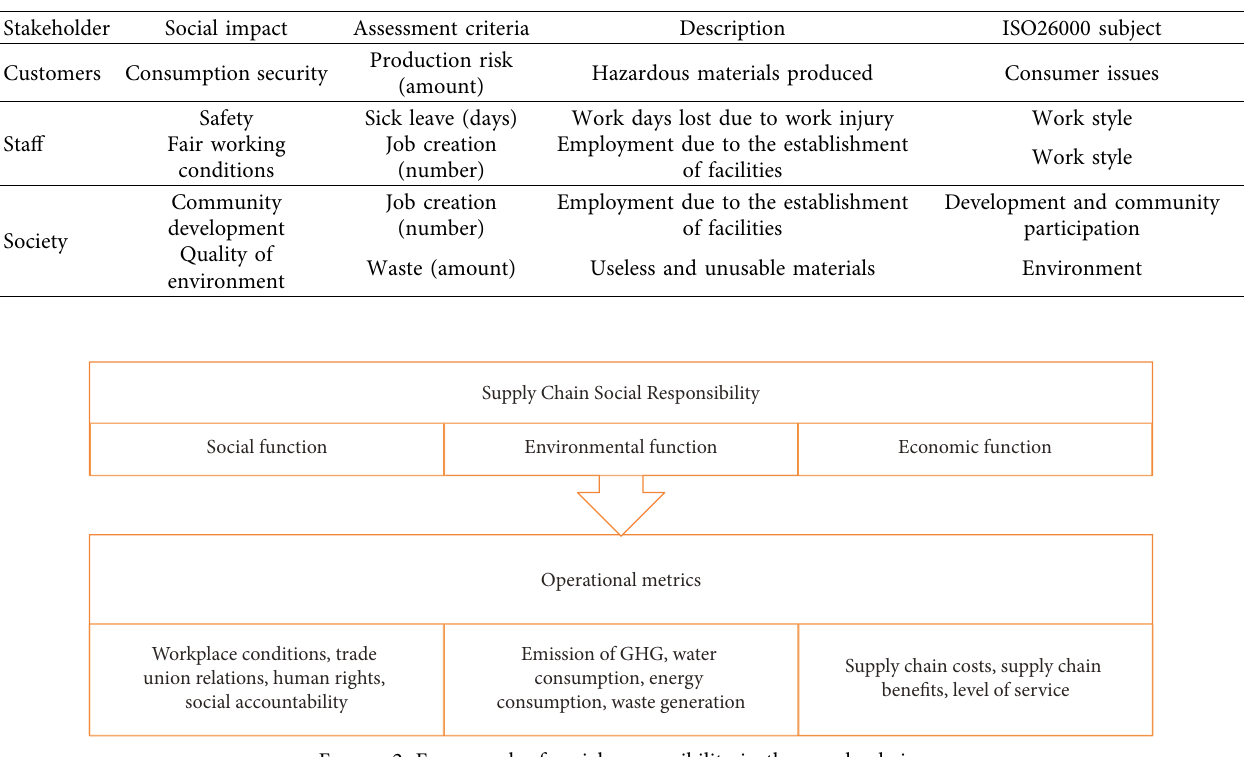
Table 5: The most important criteria for assessing social responsibility.